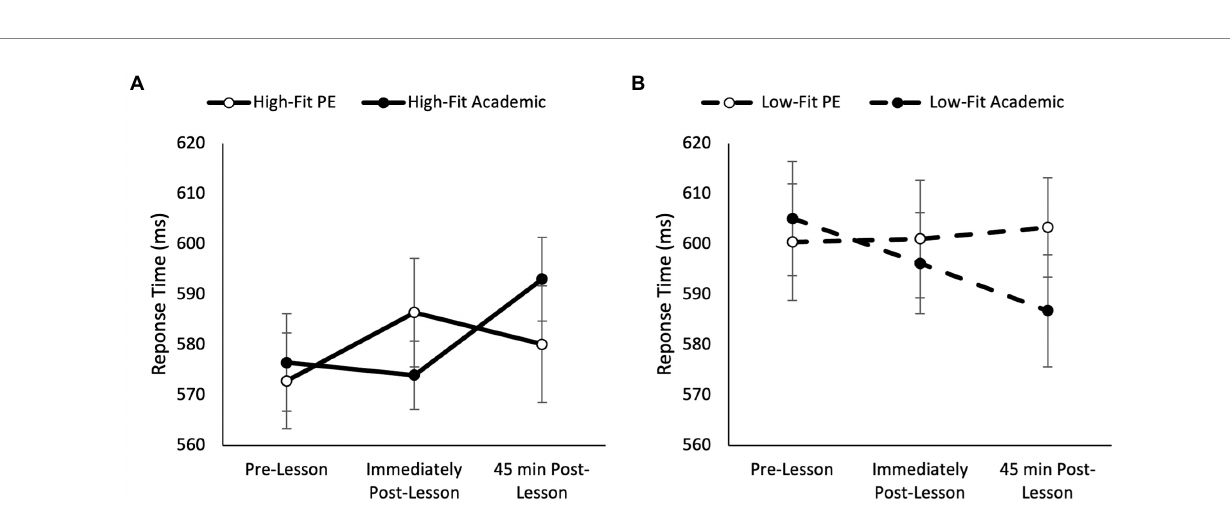
FIGURE 6 Response times across the morning on the simple level of the visual search on the PE and academic lesson trials for the high-fit (trial * time, p = 0.036; A ) and low-fit (trial * time, p = 0.130; B ) groups (trial * time * fitness, p = 0.018).